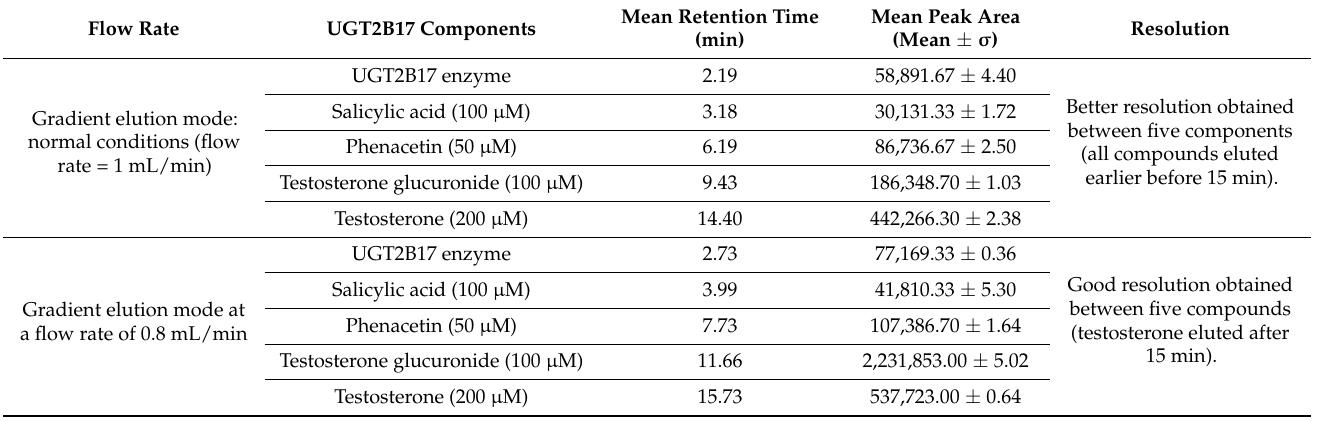
Table 2. Effect of flow rate on retention time and peak area of UGT2B17 components.